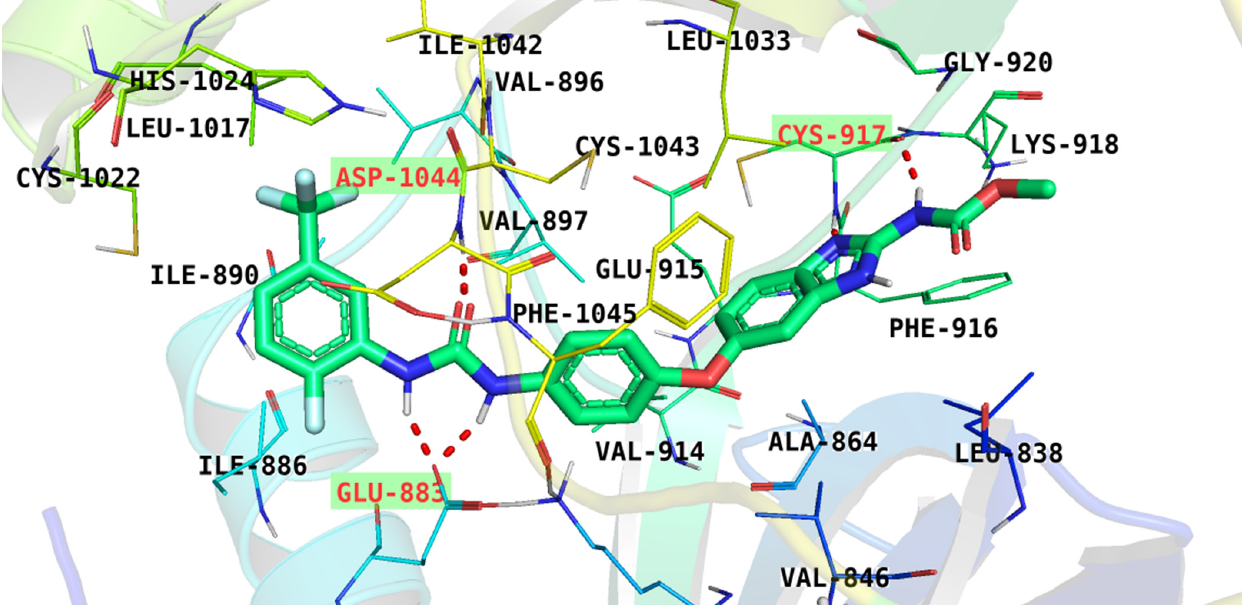
Figure 6. The binding pattern of benzimidazole ‐ urea inhibitor showing four hydrogen bonds with Cys917, Asp1044, and Glu833.